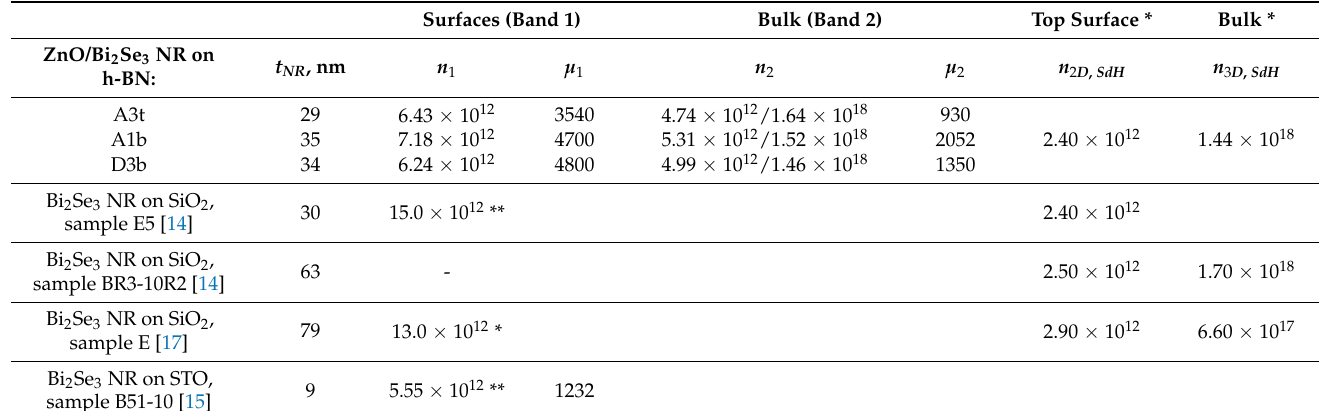
Table 1. Summary of the carrier densities (cm − 2 ) and mobilities (cm 2 /Vs) extracted from the two- band analysis and from the SdH oscillations for ZnO-encapsulated Bi 2 Se 3 nanoribbons on h-BN and SiO 2 substrates, and comparison with the literature data (refs. [14,15,17]). Surfaces (Band 1) Bulk (Band 2) Top Surface * Bulk